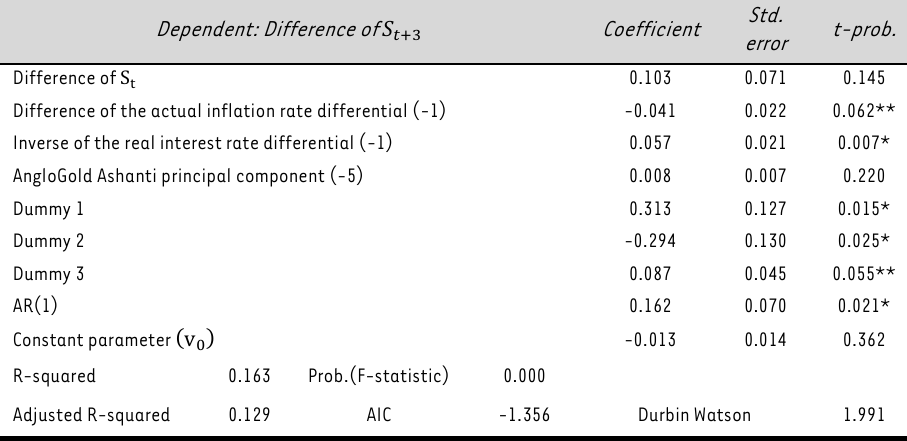
Improved multi-variable model with AngloGold Ashanti principal component – first differenced approach Dependent: Difference of Coefficient